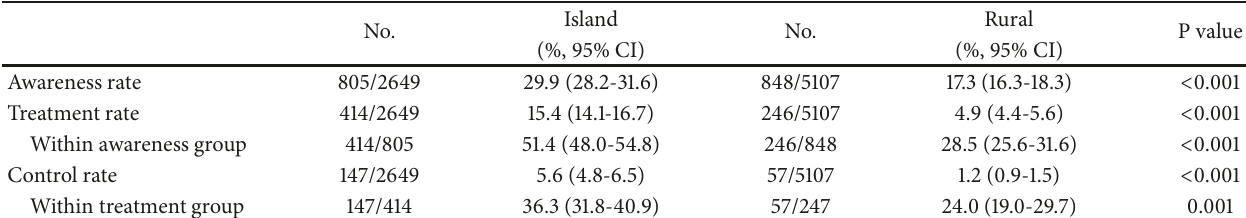
Table 6: Awareness rate, treatment rate, and control rate of hypertension in island and rural residents. No.